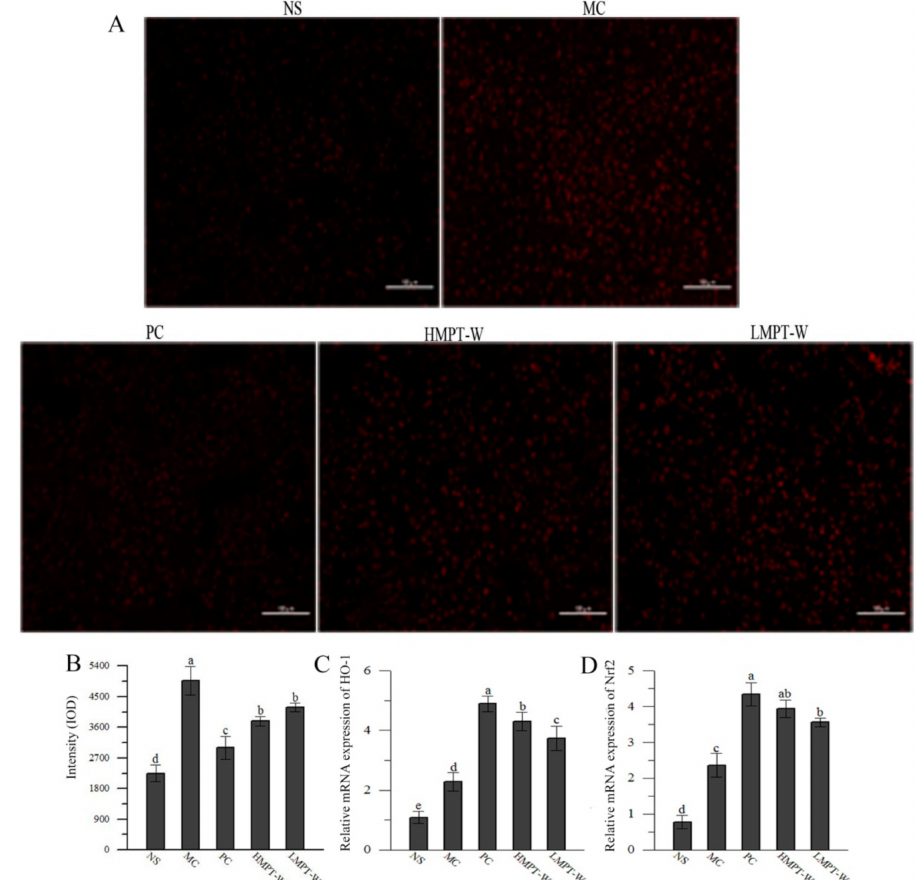
Figure 5. E ff ect of MPT-W on hepatic ROS, HO-1, and Nrf2 in CCl 4 -induced chronic liver injury mice. ( A ) ROS fluorescence labeling images of liver sections from NS, MC, PC, HMPT-W and LMPT-W treated mice, magnification 200 × ; ( B ) ROS quantification; ( C ) HO-1; ( D ) Nrf2. The values are reported as means ± SD. Bars with di ff erent letters (a, b, c, d, e) are significantly di ff erent ( p < 0.05). ROS: reactive oxygen species, HO-1: heme oxygenase-1, Nrf2: nuclear factor erythroid-2-related factor